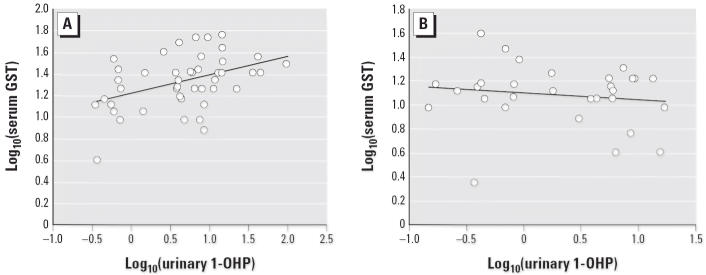
Scatter plot of correlation between log10-transformed serum GST activities and log10-transformed urinary 1-OHP levels in the exposed group (A; y = 0.1709x + 1.2198; Spearman rank correlation coefficient = 0.434; p = 0.002) and in the control group (B; y = −0.0569x + 1.1001; Spearman rank correlation coefficient = 0.076; p = 0.686).